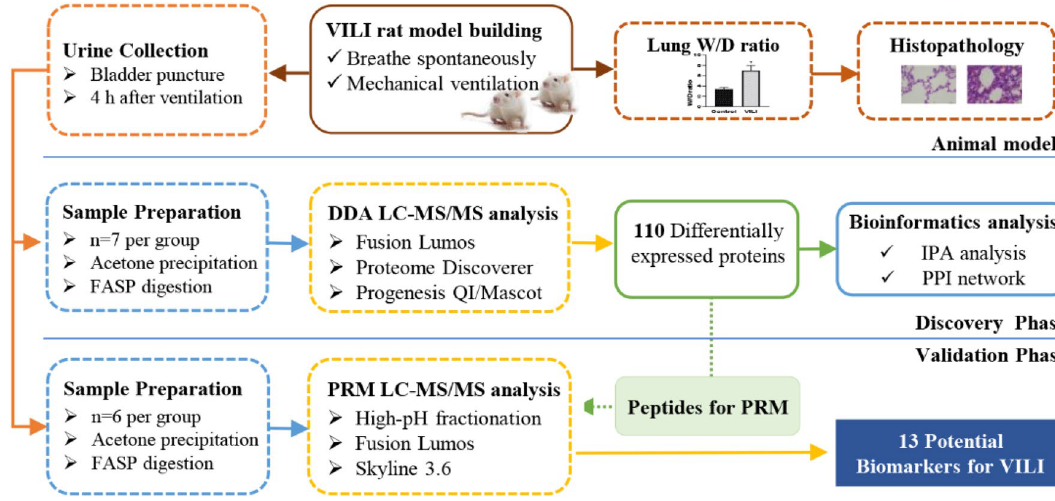
Figure 1. Workflow of the study of urine proteome changes in VILI rat model.